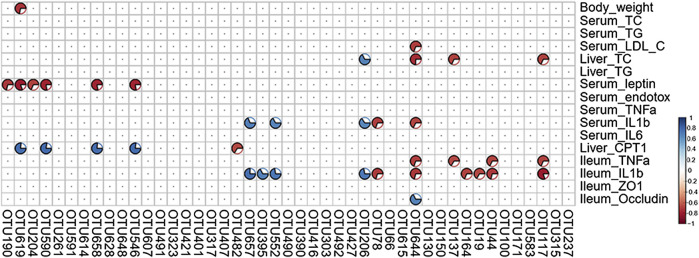
Heatmap of Spearman’s correlation analysis between key intestinal microbiota and NAFLD traits. The intensity of the color represents the degree of association (red, negative correlation; blue, positive correlation). Significant correlations are annotated by p <0.05 and absolute value of the correlation coefficient >0.5.